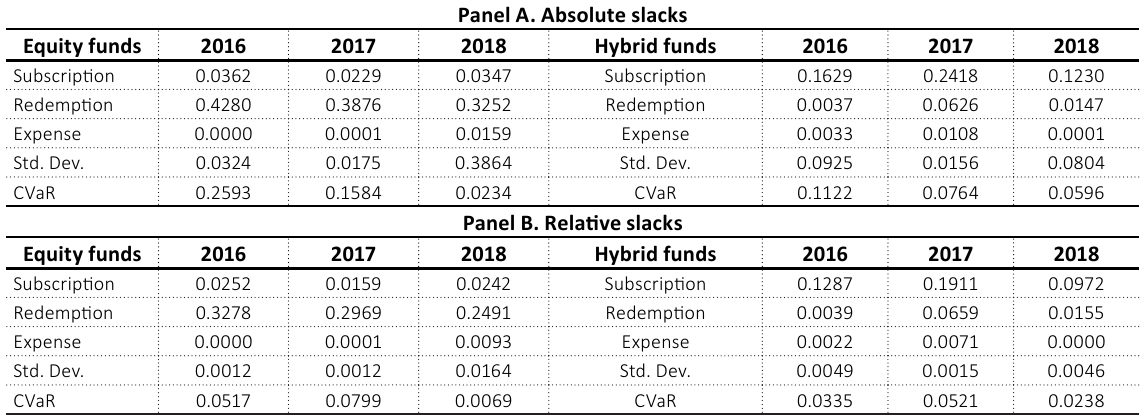
Table 4. Mean slacks in the inputs for Chinese equity and hybrid funds